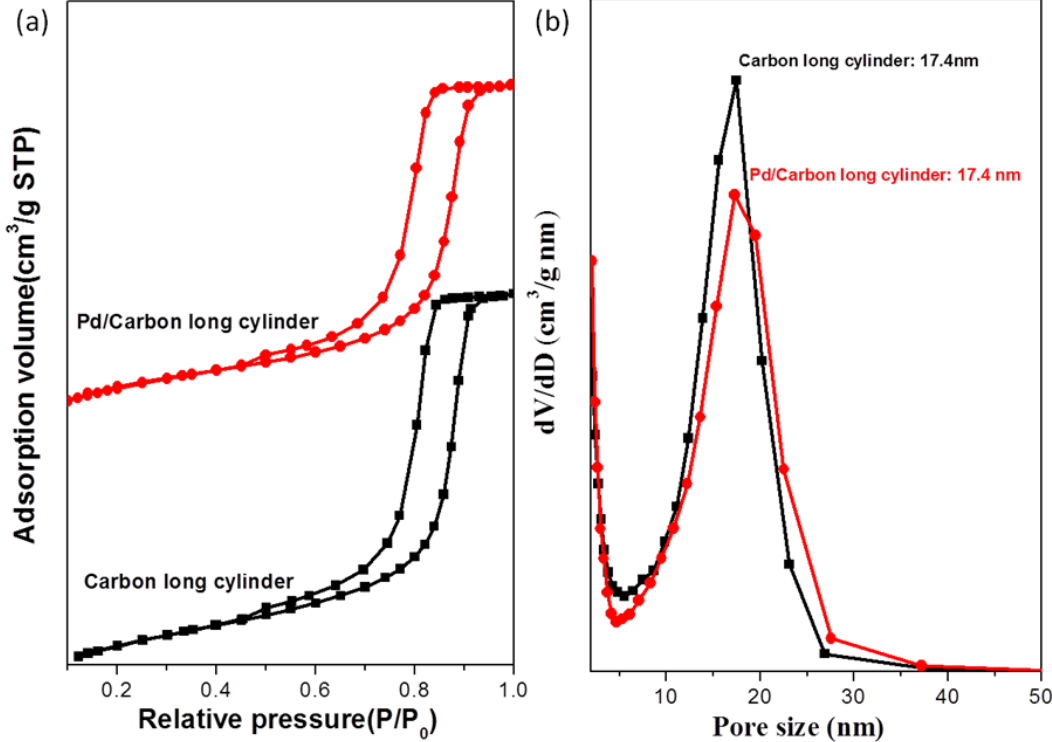
adsorption/desorption isotherms and ( b ) pore size distribution curves of Figure 6. ( a ) N 2 the hexagonal cylindrical mesoporous carbon and the Pd/cylindrical